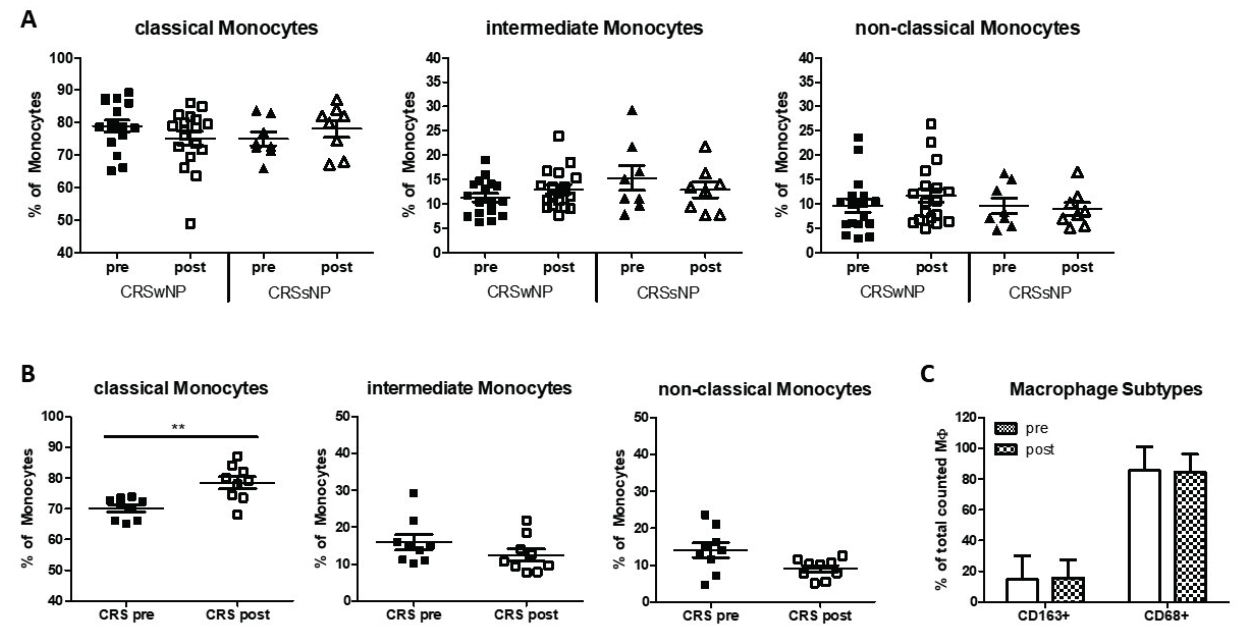
Figure 4. Flow cytometric analysis of monocyte subsets before (pre) and after (post) 1,8-Cineol treatment. A: Whole blood analysis revealed only slight shifts of the percentages of all three monocyte subsets in CRSwNP (n = 17)/CRSsNP (n = 8) patients with strong individual deviations in response to 1,8-Cineol treatment. B: CRS patients with severe monocyte alterations in peripheral blood (n = 9; less than 75% CM) showed significantly increased percentages of classical monocytes as well as decreased percentages of intermediate monocytes in response to 1,8-Cineol treatment. C: Immunofluorescence stainings of nasal polyps before (pre) and after (post) two-week 1,8-Cineol treatment. Specific primary antibodies for human CD68 and CD163 to recognize M1 and M2 macrophages revealed no significant changes in the abundance of M1/M2 macrophages in response to two-week treatment with